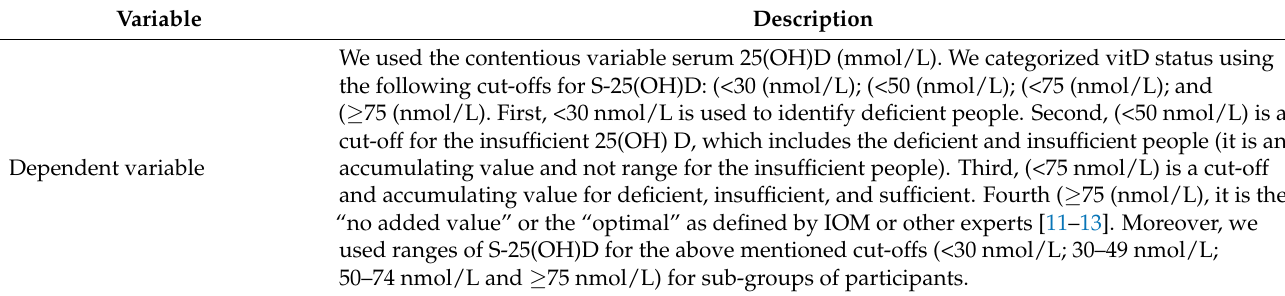
Table A1. Variables of interest in Cycles 3 and 4 of the Canadian Health Measures